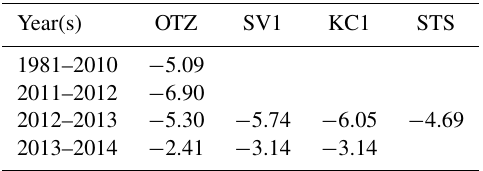
Table 2. A summary of mean annual air temperature (MAAT) for our 3 study years from the Kotzebue Airport (OTZ), our Selawik Village site (SV1), Kugurak Cabin site (KC1), and Selawik Thaw Slump site (STS). The long-term average for OTZ is also